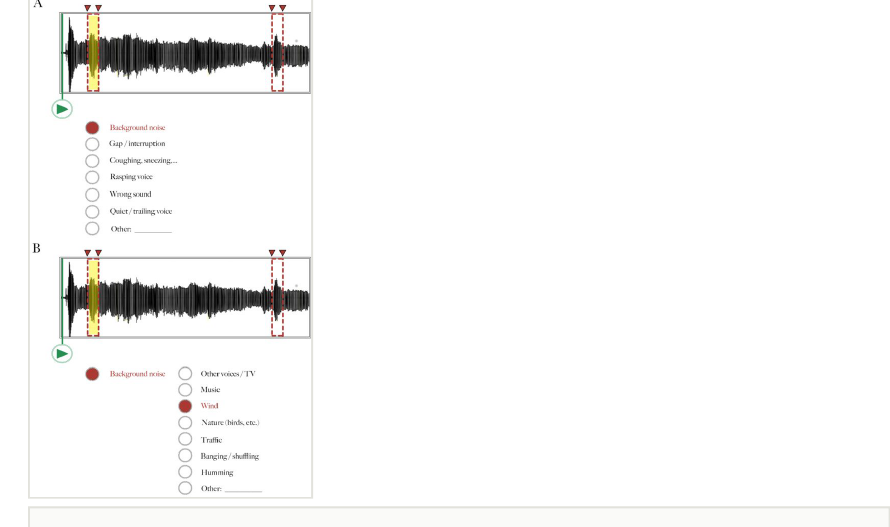
Figure 3. Audio recording annotation tool – Step 2: